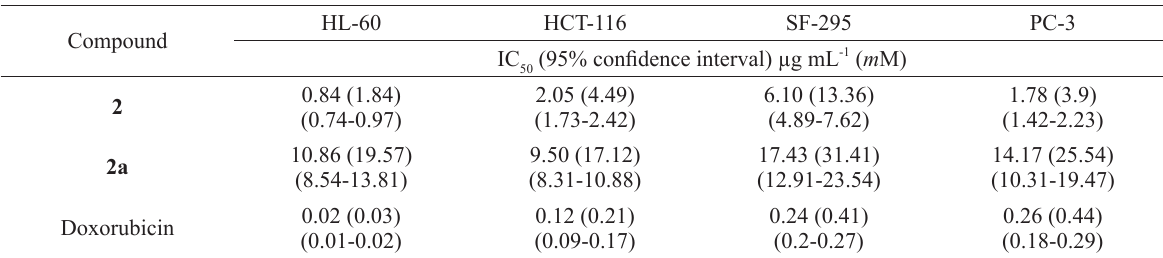
Cytotoxic activity of betulinic acid 2 and its hexanoate derivative 2a against HCT-116 (colon adenocarcinoma), SF- 295 (glioblastoma), HL-60 (leukemia) and PC-3 (prostate carcinoma) cells using MTT assay after 72 h incubation. Doxorubicin was used as positive